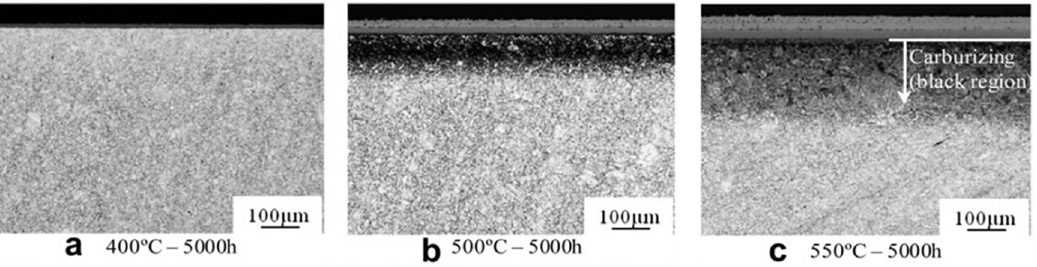
Figure 21. The microstructure of 12Cr FMs after 5000 h of exposure to (400–550 °C)/20 MPa CO 2 gas [40]. Reproduced with permission from Elsevier.